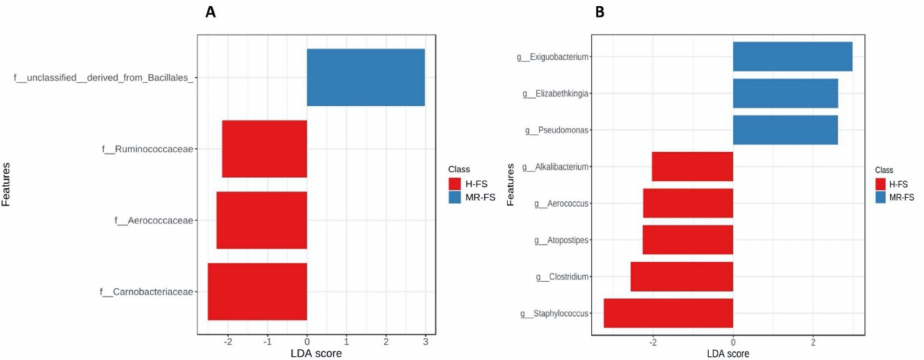
Figure 6. Linear discriminant analysis (LDA) effect size (LEfSe) at the family ( A ) and genus ( B ) taxonomic level. The horizontal bars represent the effect size for each taxon. The length of the bar represents the log10-transformed LDA score, indicated by vertical dotted lines. The red bars represented the significant OTUs of the H-FS group and the blue bars of the MR-FS